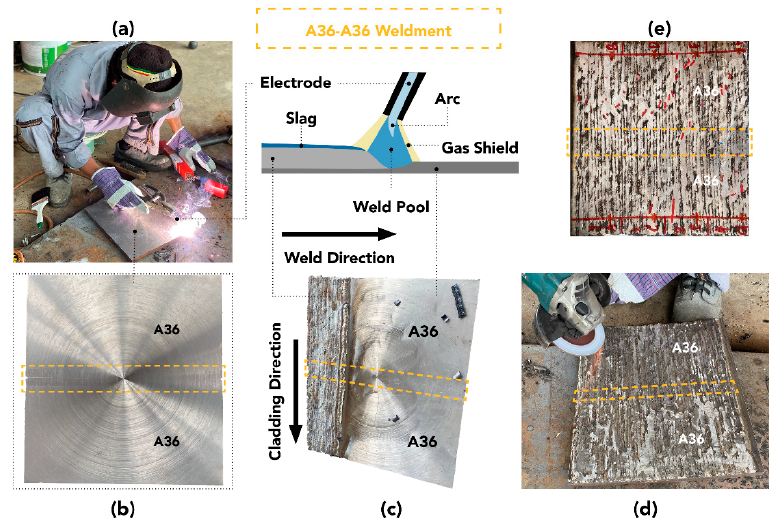
Figure 2. The illustration of the welded joint (base, HAZ, and weld metal zones).